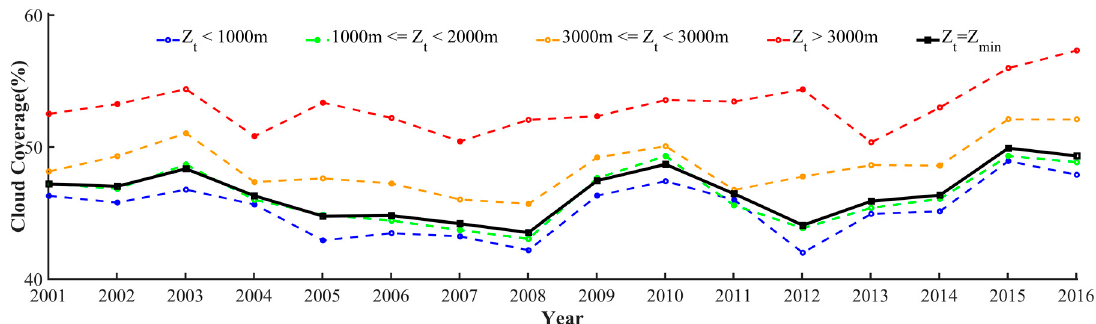
Figure 6. Annual average cloud coverage of MODIS Terra SCF product in different elevation zones.